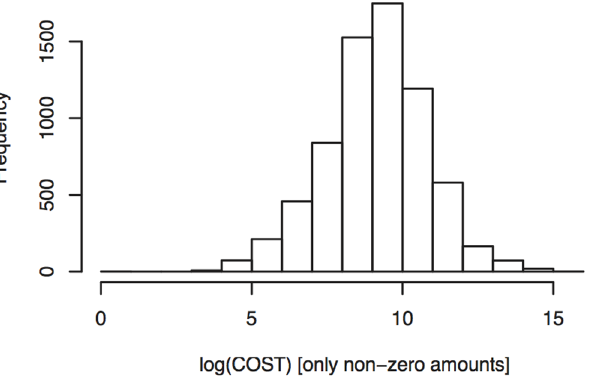
Fig 2. Histogram of non-zero payments. Histogram of log-transformed non-zero payments related to injuries.